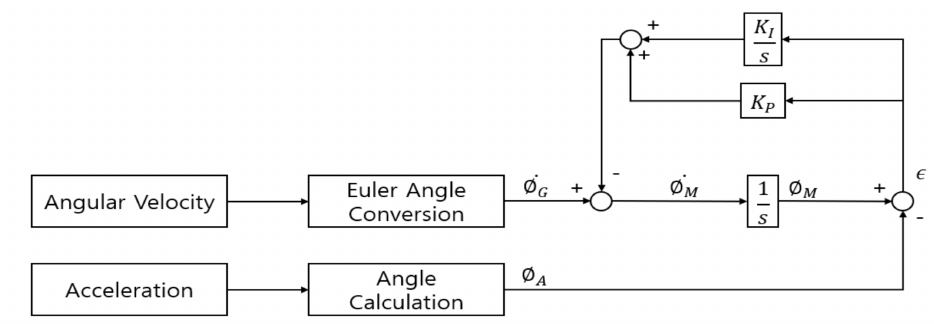
Figure 5. Gyroscope-Accelerometer fusion complementary filter with a PI